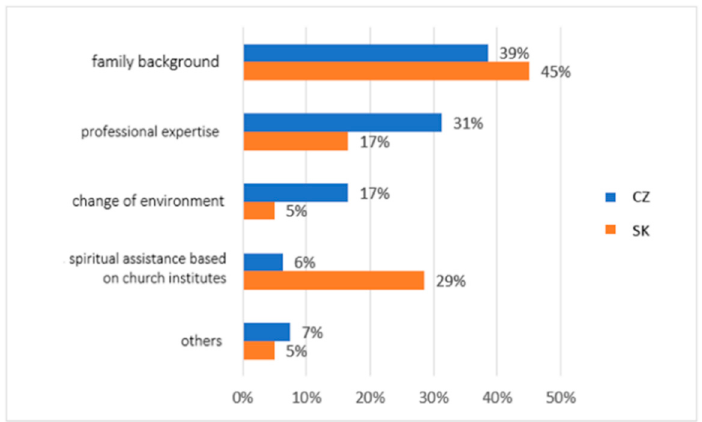
Figure 4. Descriptive statistics of the participants’ subjective perception of effective support for socially vulnerable people (comparison of the healthy population of eastern Slovakia and north-western Czech Republic). Legend: CZ—healthy population of north-western Czech Republic, SK— healthy population of eastern Slovakia. Source: own resource.